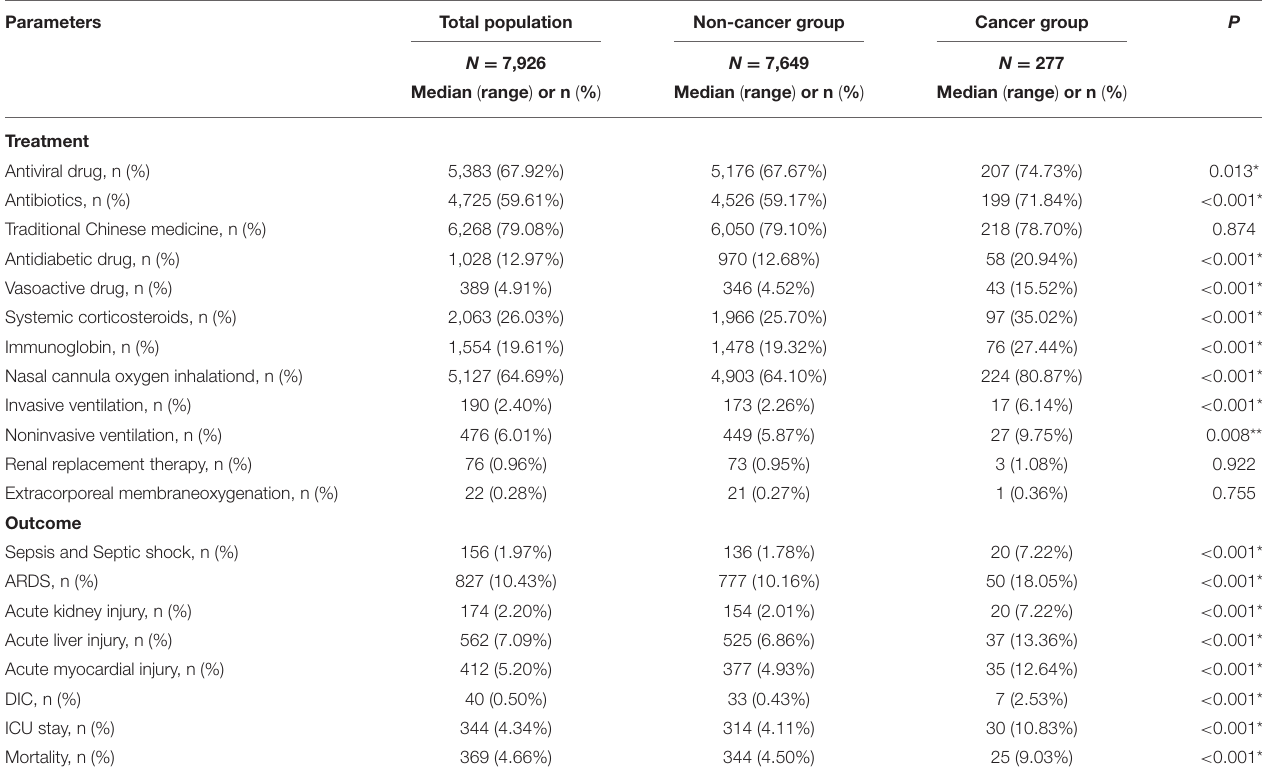
TABLE 2 | Treatment and Outcome of patients with COVID-19 in Non-cancer group and cancer group. Parameters Total population Non-cancer group Cancer group